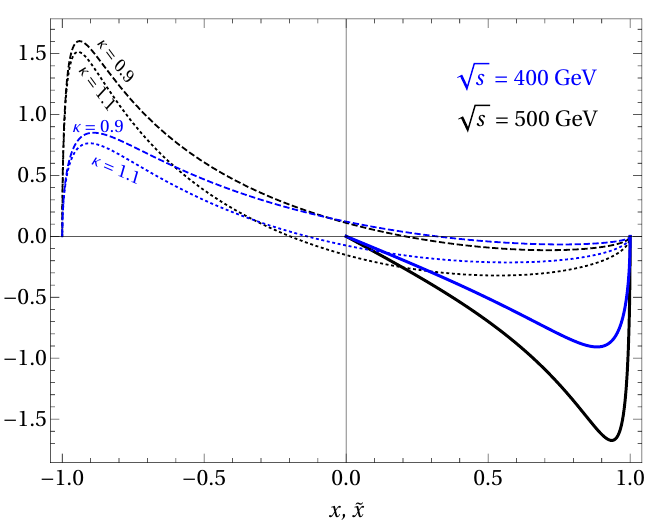
Figure 2 . Comparison of the (cid:12) ( x ) (dashed and dotted) and ~ (cid:12) (~ x ) (full line) polarization functions p at representative CMS energies s and two values of (cid:20) . We (cid:12)nd that ~ (cid:12) (~ x ) is independent of (cid:20) .